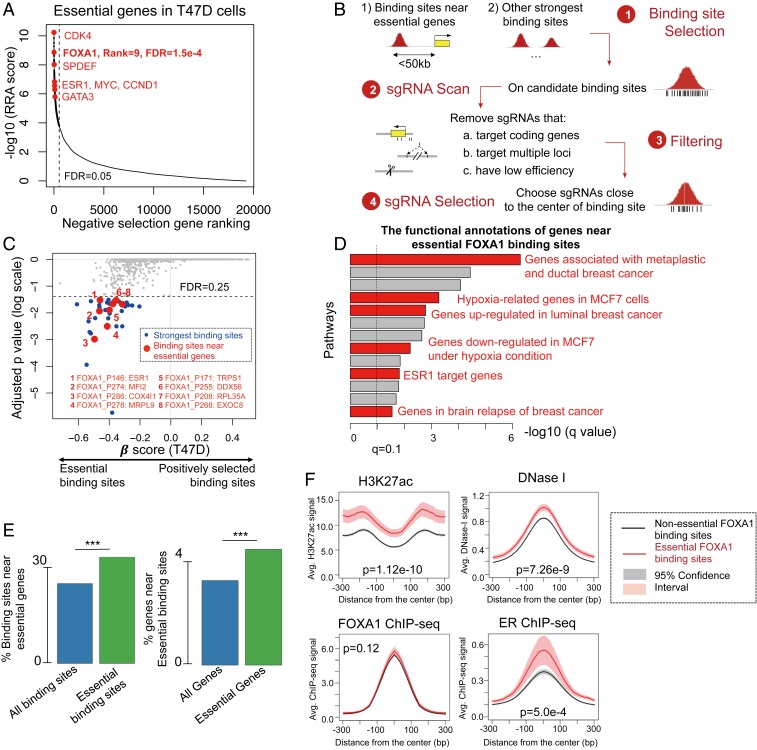
Genome-wide CRISPR screens for FOXA1 binding sites in T47D cells, an ER-positive breast cancer cell line. (A) Top essential genes in T47D cells, identified by genome-wide CRISPR gene screens. A smaller RRA score (identified by the MAGeCK algorithm) indicates a stronger negative selection of the corresponding gene. (B) The design of the FOXA1 screening library. FOXA1 binding sites are preselected as indicated, followed by an sgRNA scanning to identify all possible guides within the binding sites. sgRNAs that have low predicted specificity or cleavage efficacy are then filtered. For the remaining sgRNAs, up to 20 guides that are close to the binding site summit are then selected. (C) An overview of the functions of FOXA1 binding sites in T47D cells, including strong intergenic binding sites (blue dots) and essential binding sites near essential genes (red dots). For each binding site, the β-score, a measurement of gene selection in the screen, is calculated using the MAGeCK-VISPR algorithm that we previously developed. A positive (or negative) β-score indicates the gene/binding site is positively (or negatively) selected, respectively. (D) The functional analysis of genes near essential FOXA1 binding sites using the GREAT prediction tool (46). Terms related to breast cancer are highlighted in red. (E) The percentage of all (and essential) FOXA1 binding sites that are within 100 kb of essential genes in T47D cells, and the percentage of all (and essential) genes near essential FOXA1 binding sites. Essential genes are genes with the 10% lowest β-scores from genome-wide CRISPR gene screens in T47D cells. ***P < 0.001. (F) The epigenetic features of essential binding sites vs. nonessential binding sites.